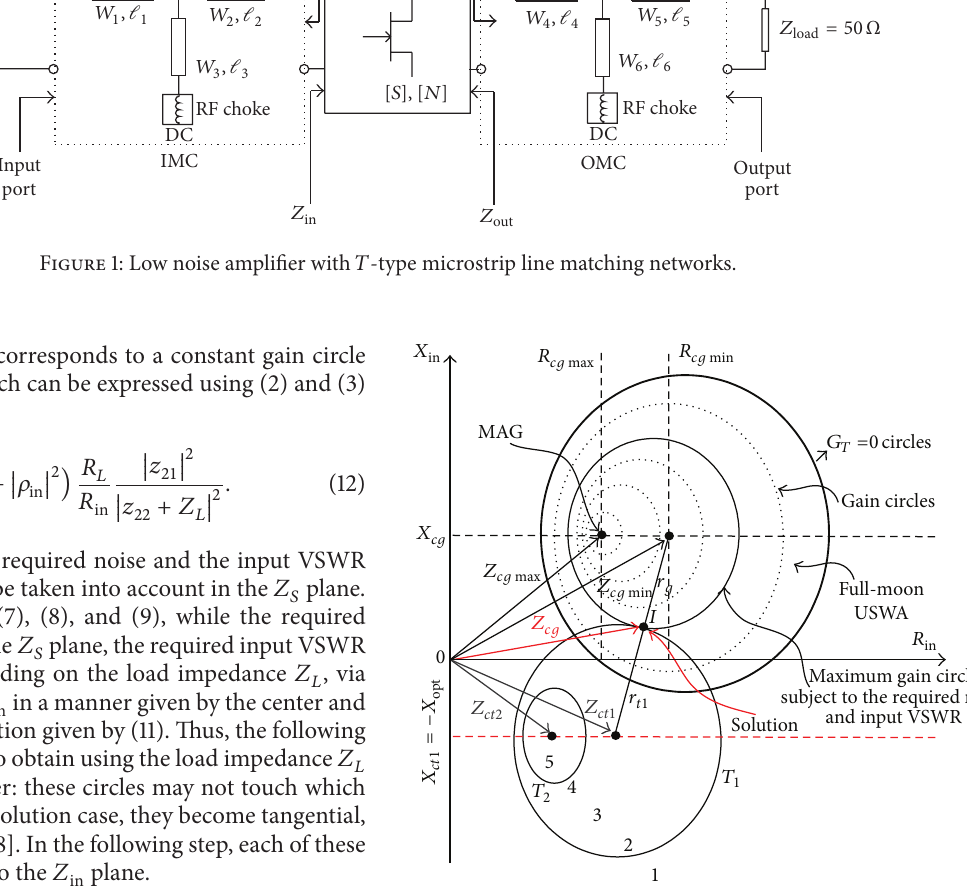
Figure 2: The full-moon USWA for the unconditional stability case is at the right hand side of the 𝑍 in